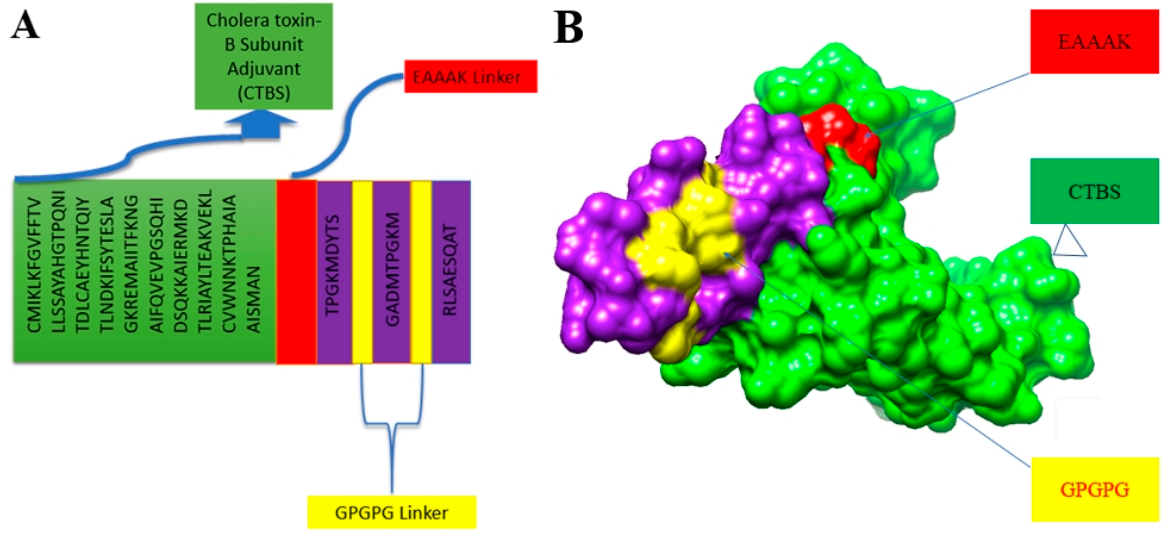
Figure 5. ( A ) Schematic representation of multi-epitope-based vaccine ( B ) three-dimensional structure of designed vaccine. Yellow color represents GPGPG linkers. Light green color is of cholera toxin B subunit adjuvant, while red color represents EAAAK linker.